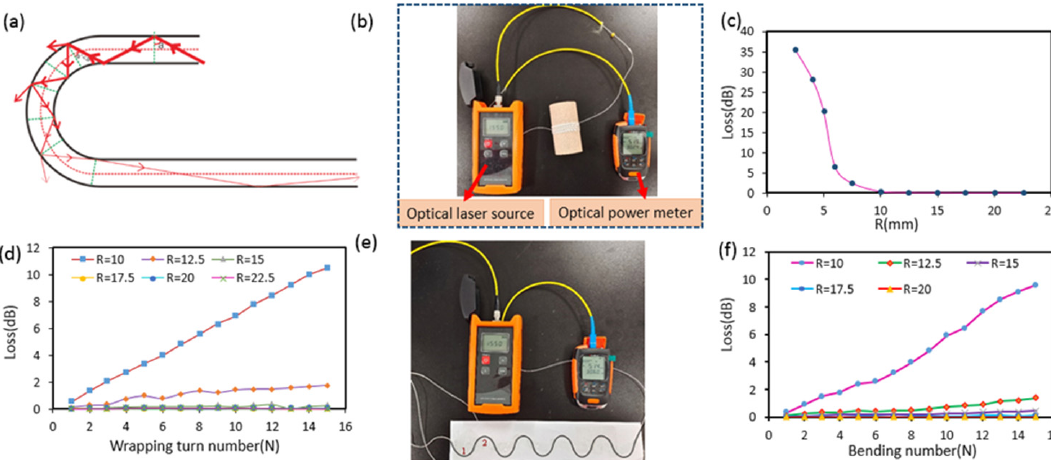
Figure 7. The bending loss test of the optical fiber. ( a ) The light guiding properties when the optical fiber is bent. ( b ) Schematic diagram of the optical set-up for measuring the loss of optical fibers with different radiuses and wrapping turn numbers. ( c , d ) The variation of loss against the bending radius and wrapping turn number. ( e ) Schematic diagram of the optical set-up for measuring the loss of optical fibers with different curves. ( f ) Variation of loss against the path bending number.